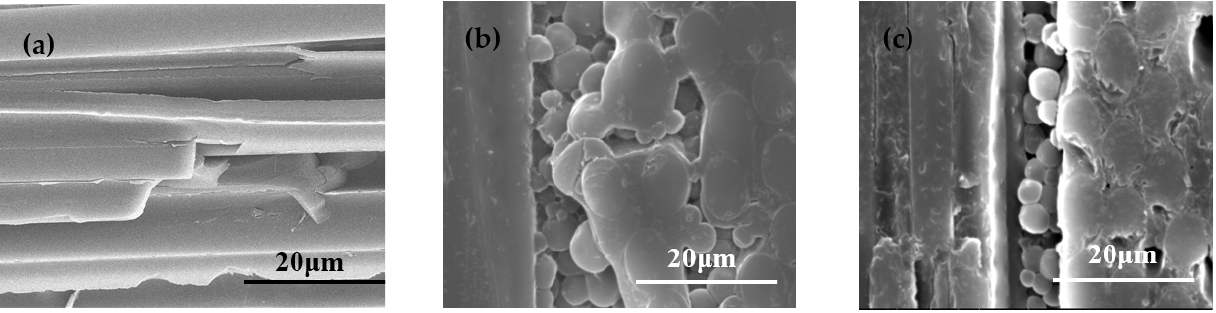
Figure 9. SEM images of CF/BMI ( a ), CF/PEK-C/BMI ( b ), and CF/BT5501A/PEK-C/BMI ( c ) compo- Figure 9. SEMimagesofCF/BMI( a ), CF/PEK-C/BMI( b ), andCF/BT5501A/PEK-C/BMI( c ) sites.